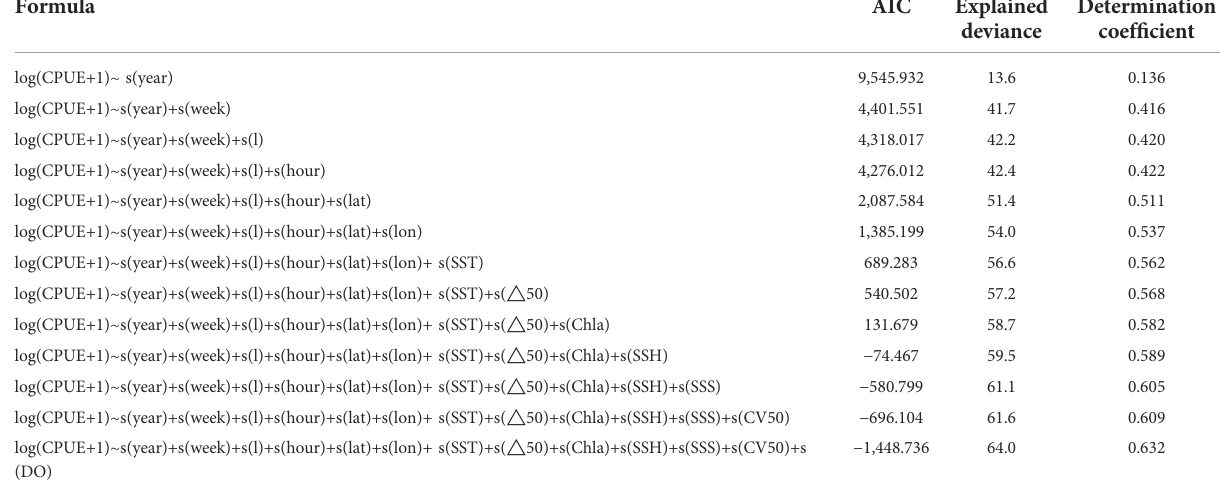
TABLE 1 GAM model statistical results (Akaike ’ s Information Criterion, AIC).